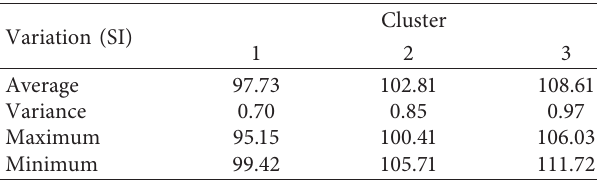
Table 5: Clustering analysis results of the noise level of concrete pavement.